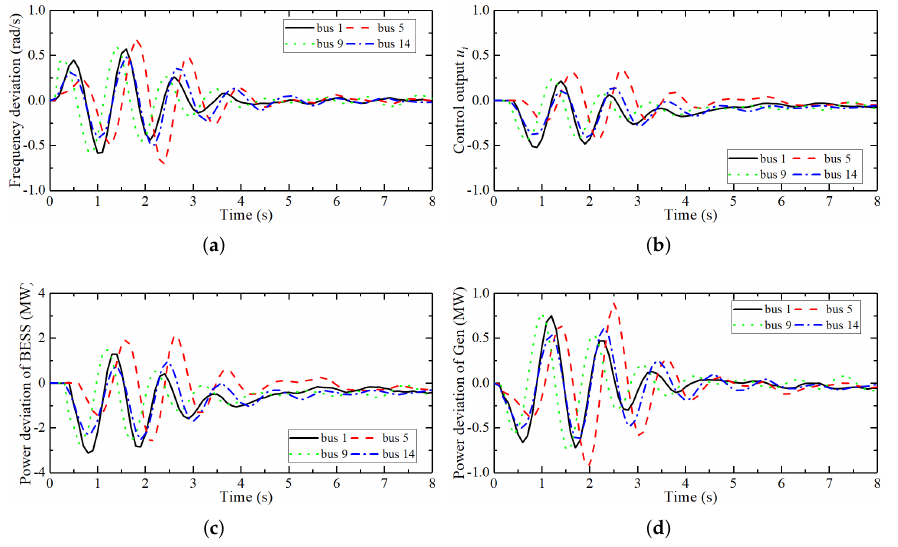
Figure 9. Frequency deviation, control output, BESS and power output deviation of the generator in IEEE14 bus testing system, η ji = 0.2. ( a ) Frequency deviation. ( b ) Control output u i . ( c ) Power deviation of BESS. ( d ) Power deviation of generators.